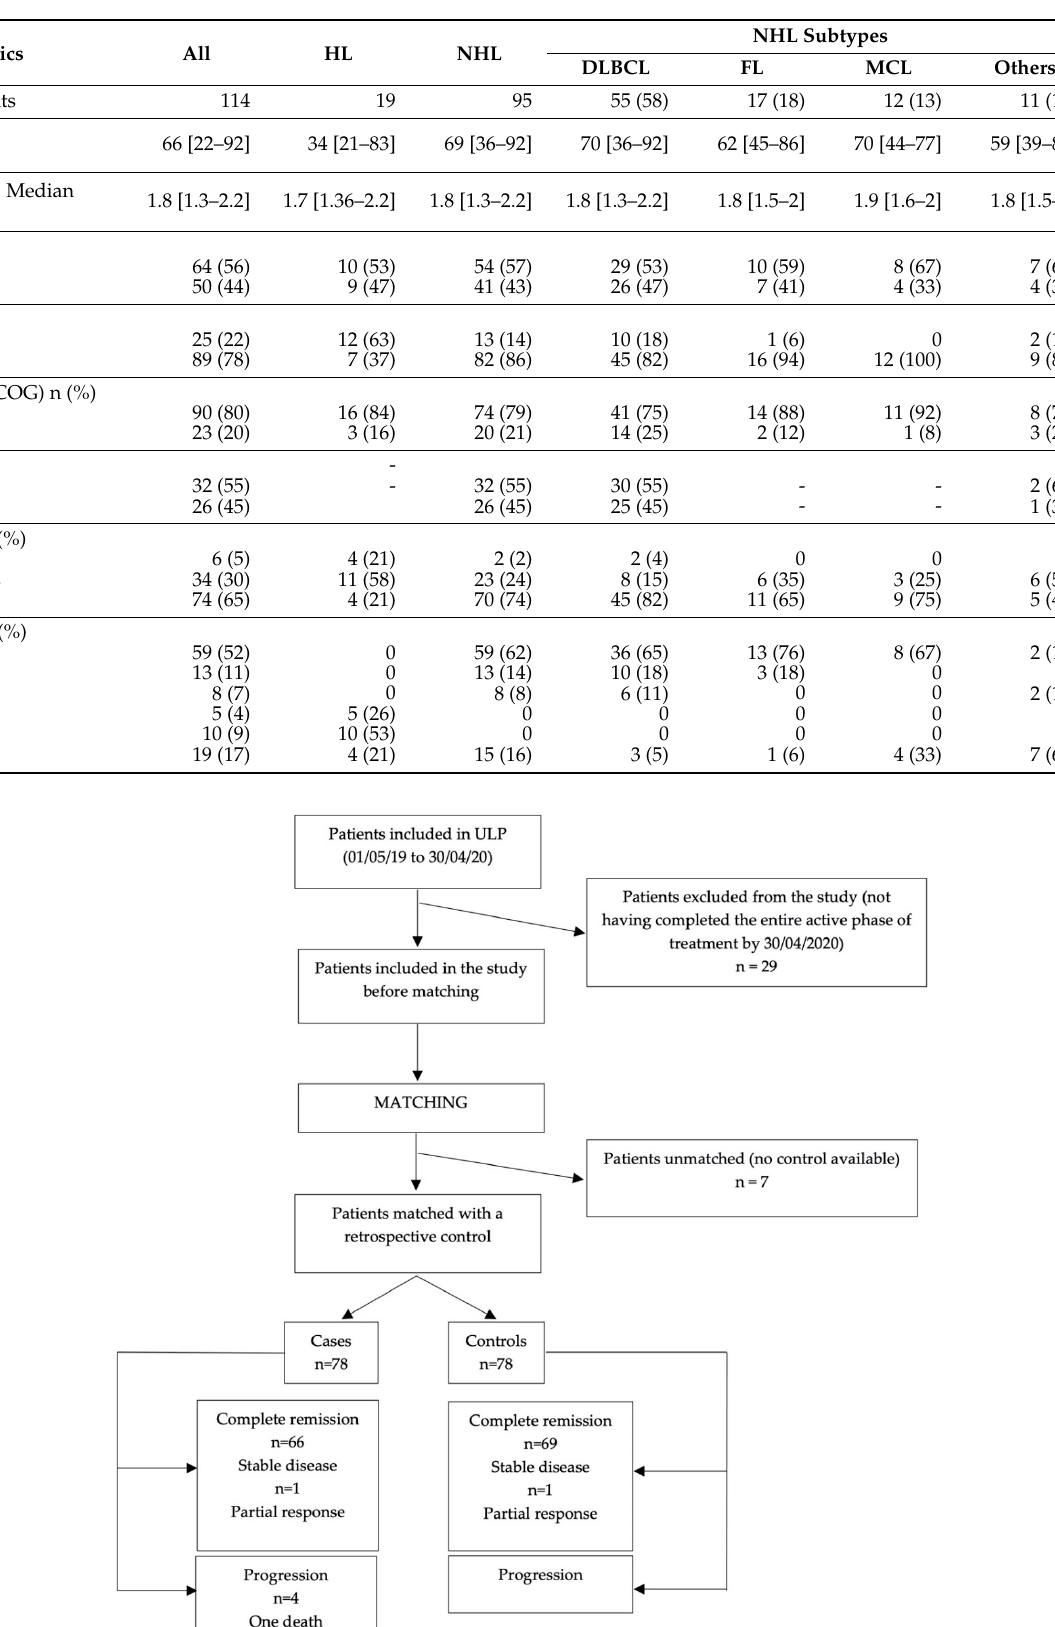
Table 1. Characteristics of our UMACOACH Lymphoma population.